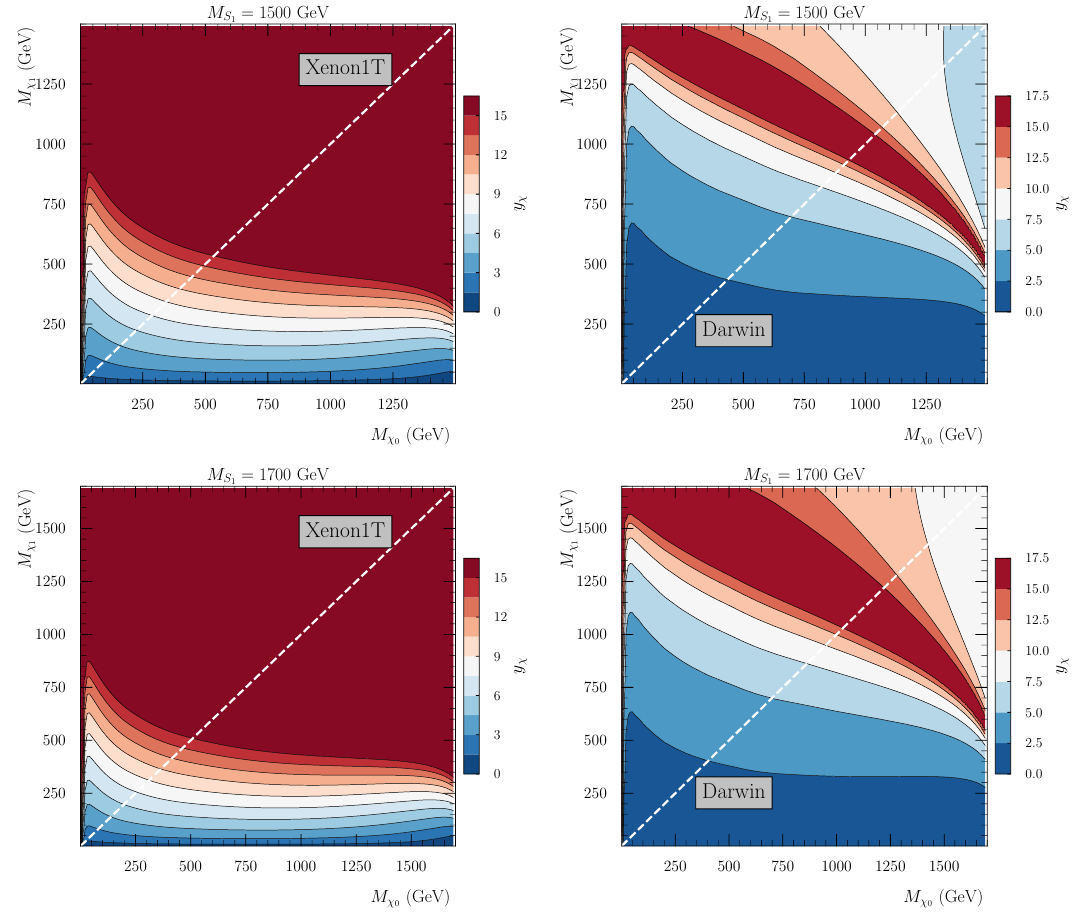
Figure 12 . Contours of excluded values of y χ originating from the spin-independent direct de- tection cross section constraints in Xenon1T [87] (left) and from the expectation of the DARWIN experiment [88] (right). These contours are projected on the plane spanned by M χ and we assume M S = 1500 GeV (upper panels) and M S 1 dashed line corresponds to the kinematical boundary ( M χ dark-matter